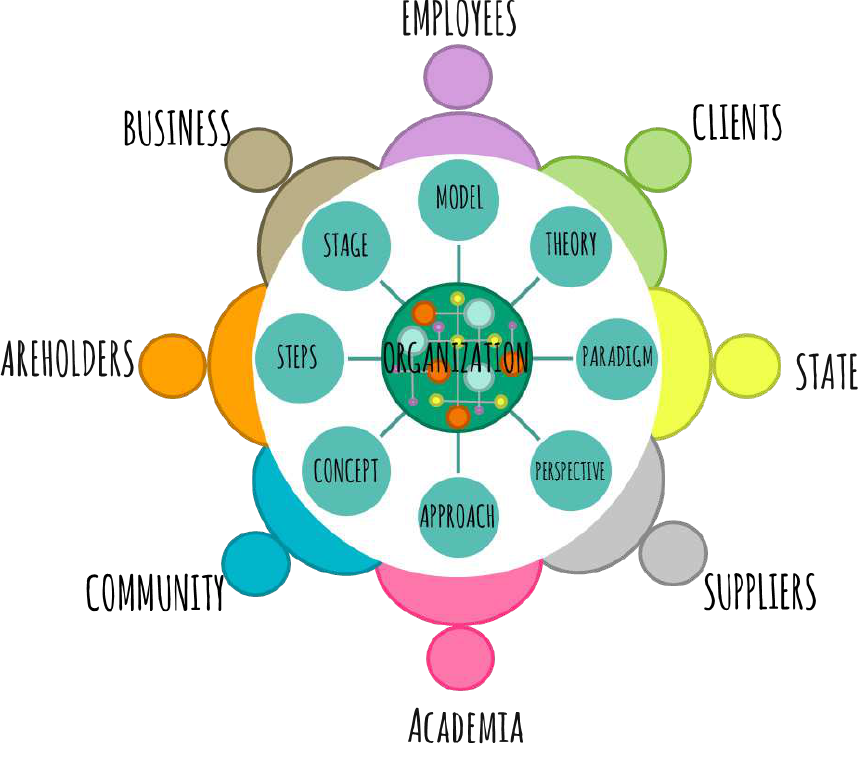
Figure 2. Model proposed for managing innovation by companies based on